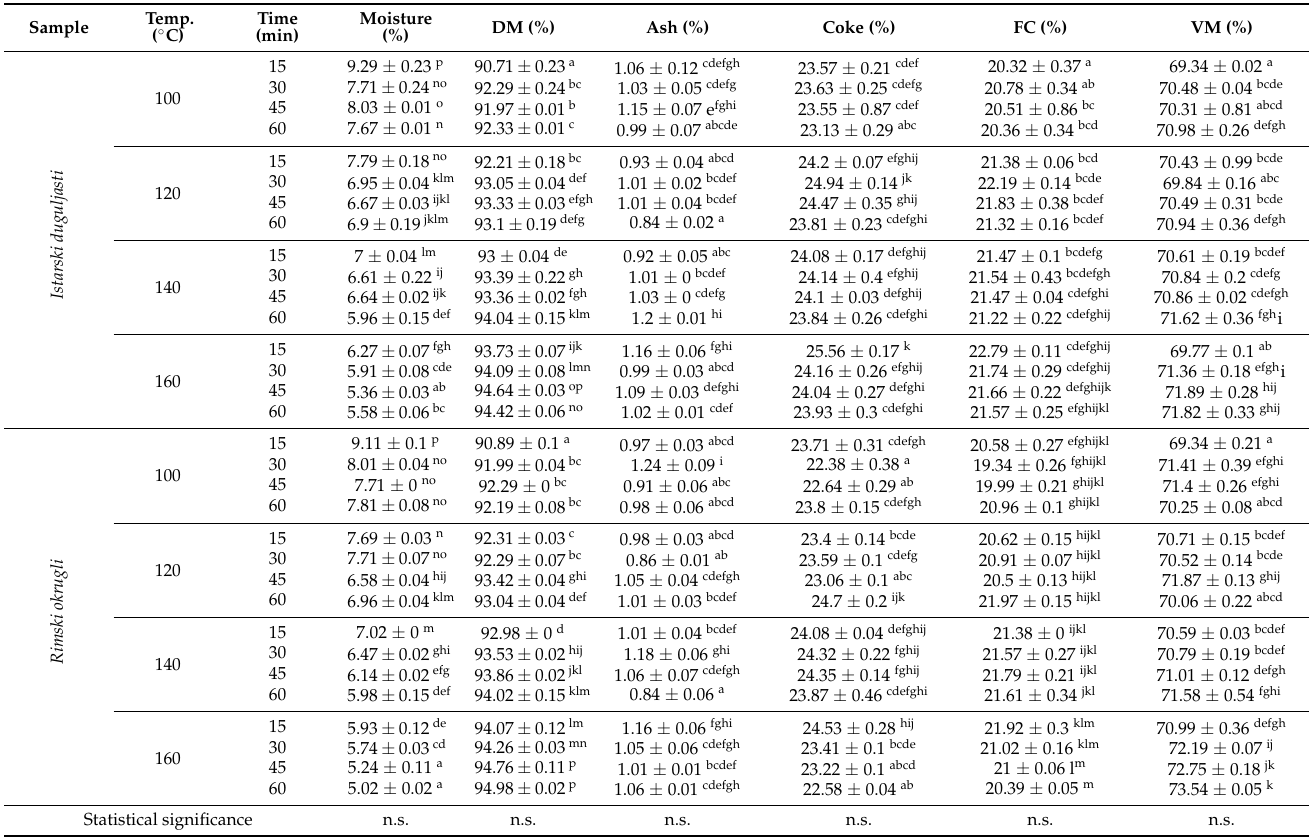
Table 4. Proximate analysis of observed hazelnut varieties after drying